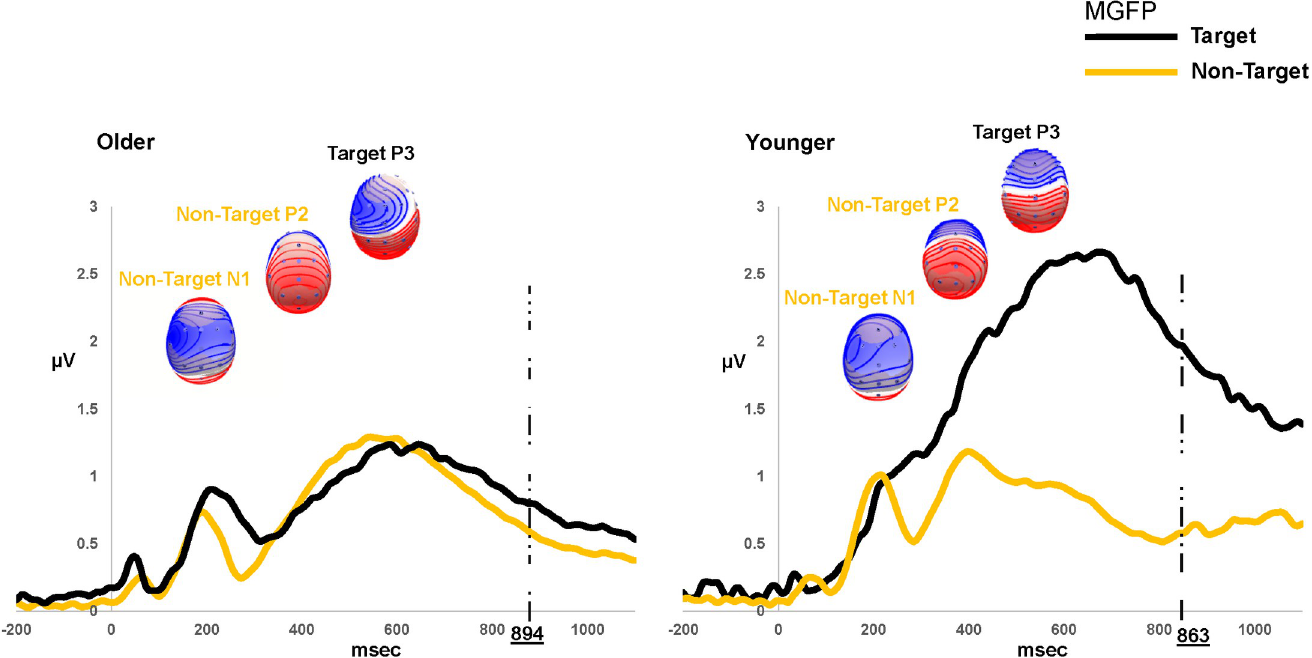
Fig 4. Grand-averaged mean global field power (MGFP) waveforms for the target and non-target stimulus processing for the older and younger participants. The corresponding scalp maps for the major ERP components; N1, P2 (Non-target) & P3 (Target), are displayed with positive values in red and negative values in blue. The dashed line shows the mean reaction time (averaged across conditions) for each